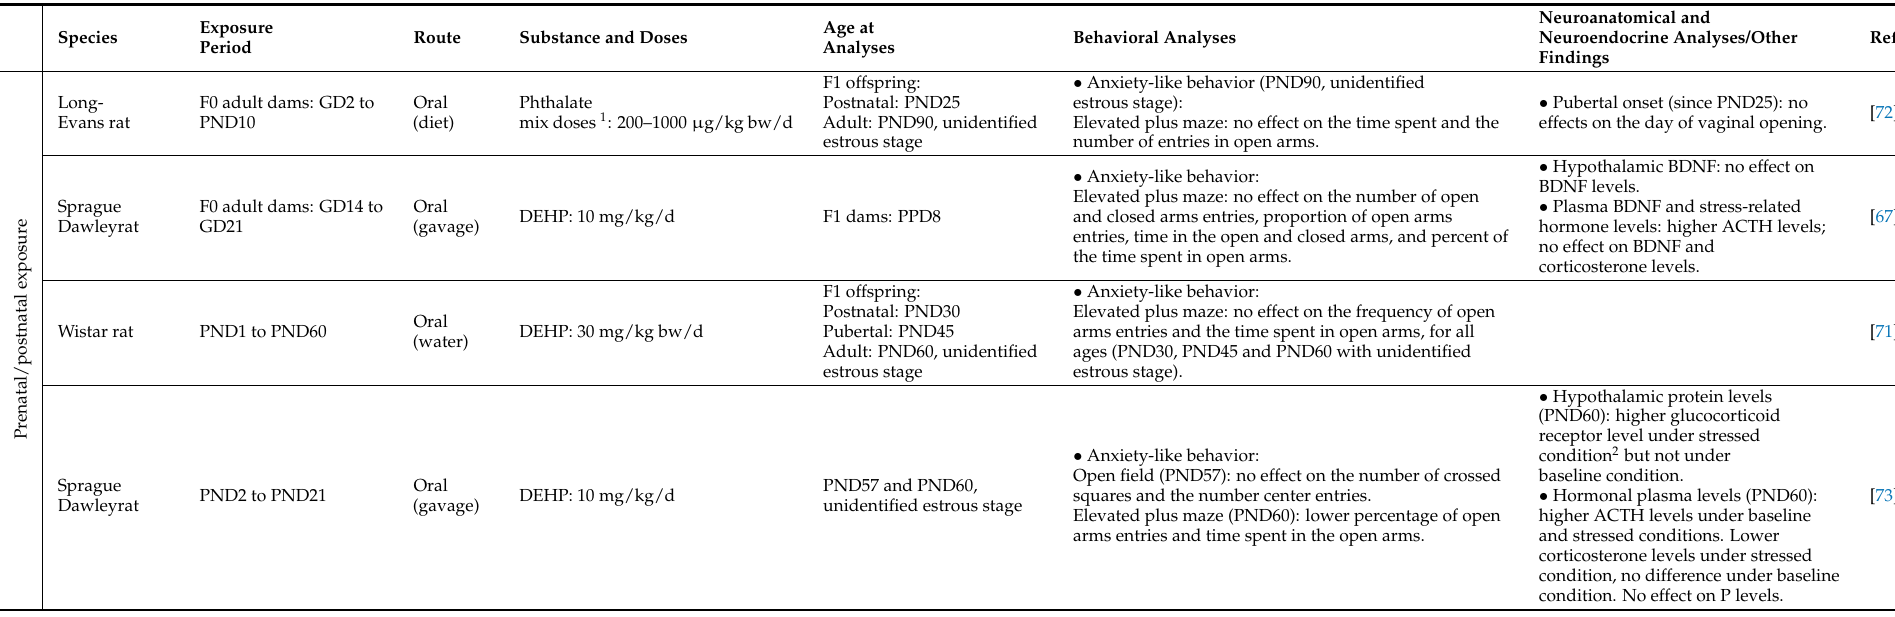
Table 2. Effects of phthalate exposure on mood-related behaviors. ACTH, adrenocorticotropic hormone; Akt, protein kinase B; AR, androgen receptor; BBP, benzyl butyl phthalate; BDNF, brain-derived neurotrophic factor; CREB, cAMP response element-binding protein; CRH, corticotropin-releasing hormone; D1R and D2R, dopamine receptor 1 and 2; DBP, dibutyl phthalate; DEHP, Di-(2-ethylexyl) phthalate, DEP, diethyl phthalate; DiBP, diisobutyl phthalate; DINP, diisononyl phthalate; DNMT, DNA methyltransferase; E 2 , estradiol; Esr1 and 2, estrogen receptor 1 and 2; ER β , estrogen receptor β ; ERK, extracellular signal-regulated kinases; FSH, follicle stimulating hormone; GD, gestational day; GR, glucocorticoid receptor; LH, luteinizing hormone; MeCP2, methyl-CpG binding protein 2; MR, mineralocorticoid receptor; NR43A1 and 3, Nuclear Receptor Subfamily 4 Group A Member 1 and 3; P, progesterone; PND, postnatal day; PPD, postpartum